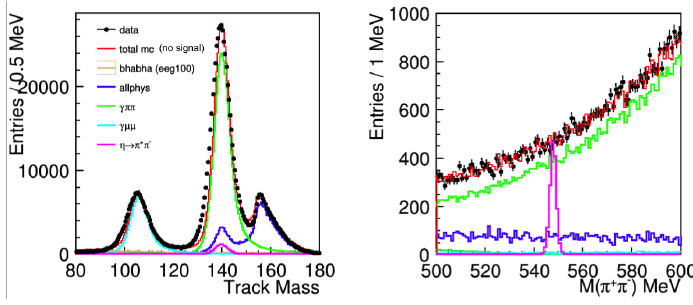
Figure 7. Left: distribution of the mass of the charged tracks; Right: two track invariant mass in the region of the η mass, the peak of η → π + π − has been generated by MC with an arbitrary branching